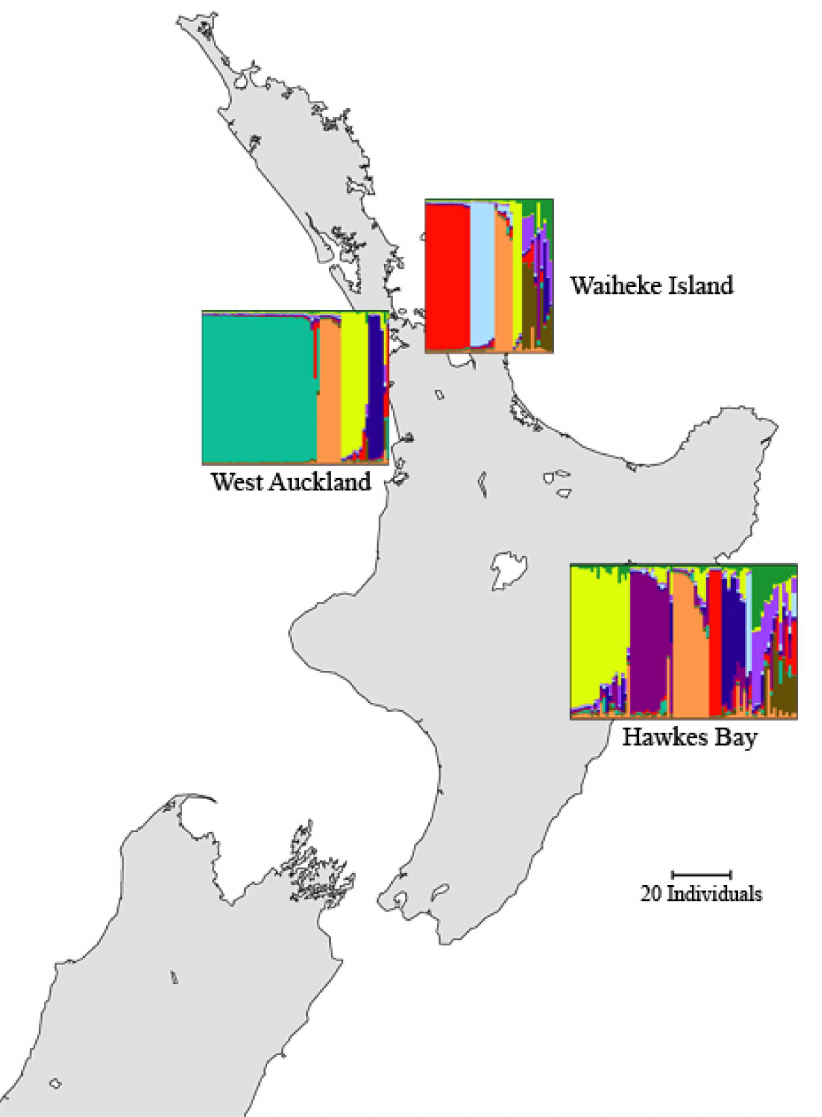
Figure 3.Map of New Zealand showing DISTRUCT plots of ancestry profiles for 179 S.cerevisiae sampled from three regions from [ 19 ] . Ancestry profiles were generated using InStruct with K ~ 10